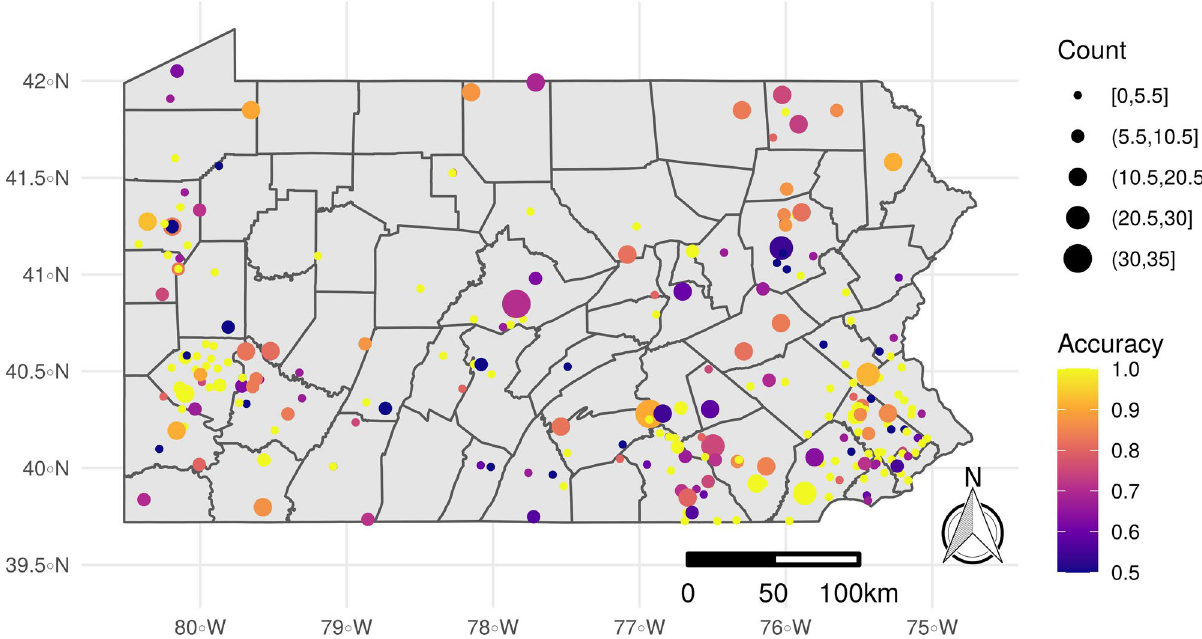
Figure 3. Prediction accuracy of the Random Forest model of overwintering survival probability from the colony model, averaged by apiary for mapping purposes. The dataset used to generate the accuracy map contained 1429 colonies within 257 apiaries. The color indicates the mean overall model accuracy at that apiary, and the circle size is proportional to the number of colonies in November. The map has been generated by the authors in R 3.6.2 50 , using the sf 72 , the raster 56 , the ggplot2 73 and the cowplot 74 packages.